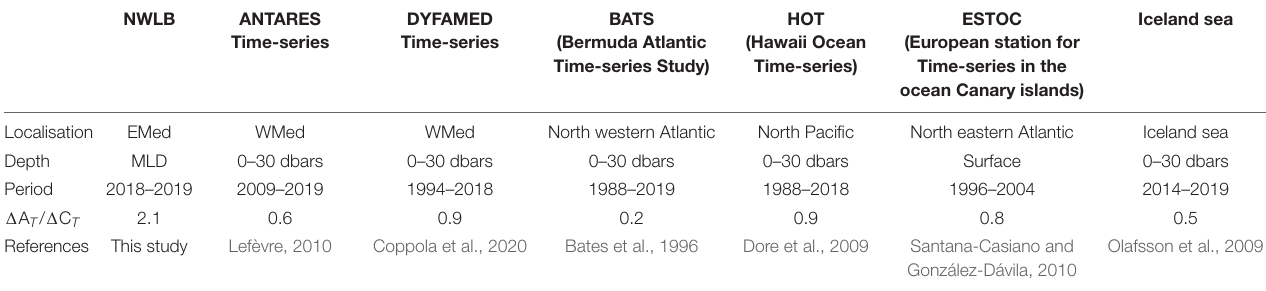
FIGURE 4 | A T vs. Salinity during PERLE0 and PERLE2 cruises within the mixed layer for all stations situated in the North Western Levantine Basin. The colour scale corresponds to the mixed layer depth (MLD–dbars). The black line corresponds to the significant linear regression (in the NWLB). The different grey lines correspond to the linear regressions between A T and salinity in the surface EMed reported by Schneider et al. (2007), Cossarini et al. (2015), Hassoun et al. (2015a), and Gonzaìlez-Daìvila et al. (2016). The grey dots correspond to data in the Cretan Sea (not used in the linear regression). TABLE 2 | Ratios ( (cid:49) A T / (cid:49) C T ) of the range in A T variations (maximum value minus minimum value) to the range in C T variations (maximum value minus minimum value) in the upper ocean for the different time-series.